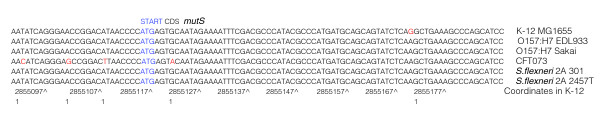
Small sample segment of the alignment spanning the start of the mutS gene (denoted in blue). Location of a mismatch is indicated by the integer '1' along the bottom row. Five columns contain SNDs: TTTCTT, AAAGAA, AAATAA, GGGAGG, and GAAAAA. The first four share the same bipartition pattern (111211) and are deemed equivalent, even though one of them results from a transversion. The other SND is considered distinct despite having the same mutation (A to G) found in the second SND.